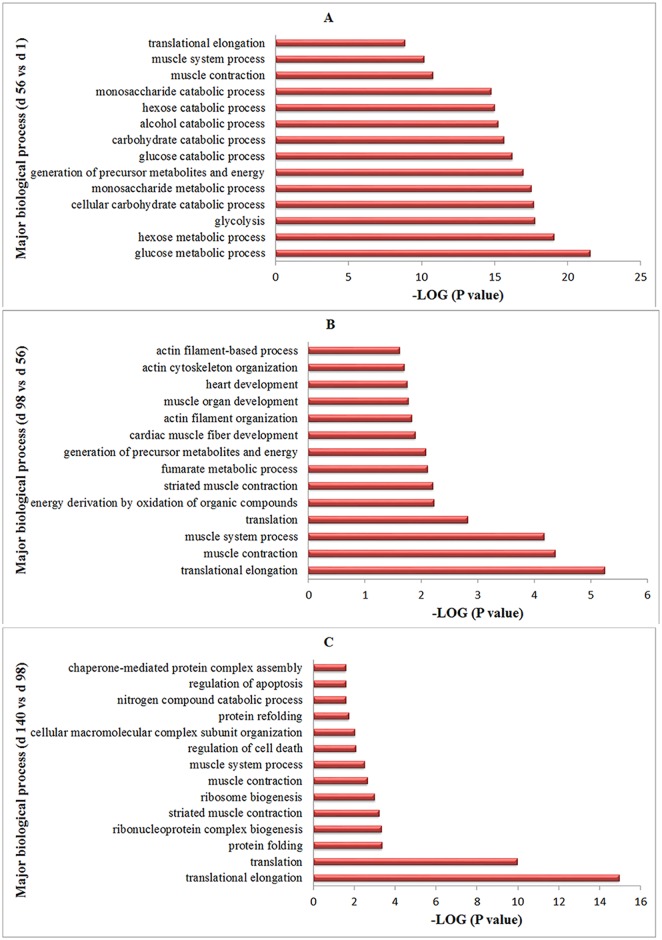
Biological processes of the differentially expressed proteins identified for three stages.The identified proteins were grouped into 15 categories according to their biological process for every stage (GO term with P-value < 0.05). Glucose and intermediary metabolism, muscle development, translation and protein folding were the major biological processes from day 1 to 56, day 56 to 98, and day 98 to 140.